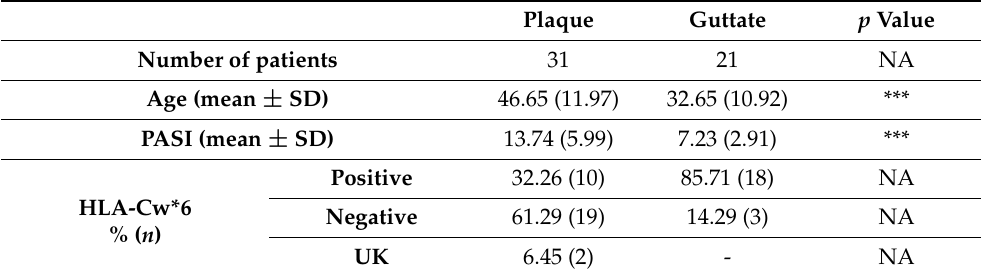
Table 1. Clinical features of psoriasis patients in cohort 1 according to the subtype of disease.